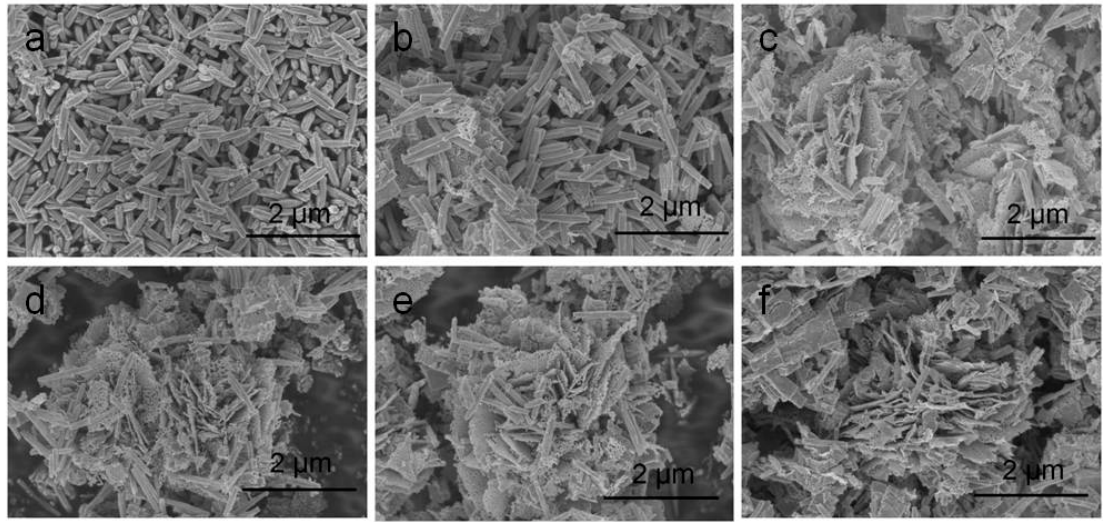
Figure 3. Scanning electron microscopy (SEM) microstructure diagram of the sample: ( a ) In 2 O 3 -0.5 h; ( b ) In 2 O 3 -2 h; ( c ) In 2 O 3 -4 h; ( d ) In 2 O 3 -6 h; ( e ) In 2 O 3 -8 h; ( f ) In 2 O 3 -10 h.